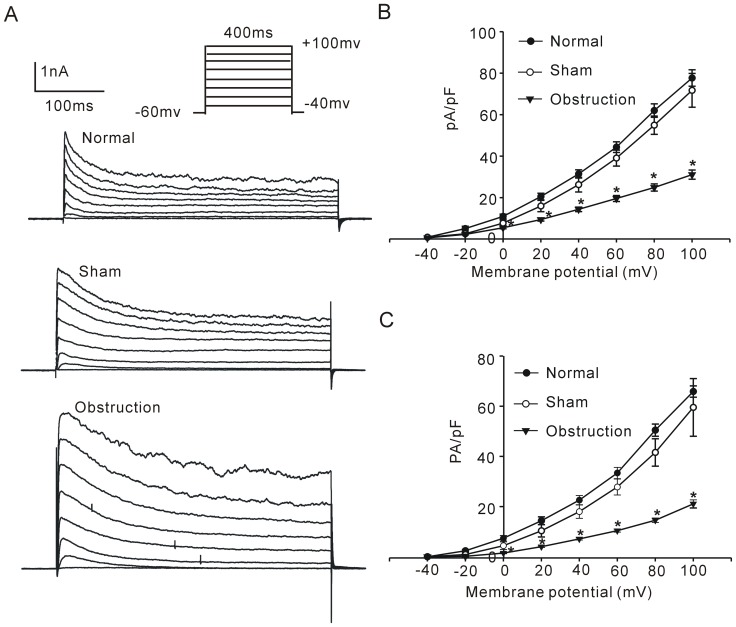
Comparison of IKV in normal sham and obstruction groups.A shows representative current traces elicited from a holding potential of −60 mV using voltage steps of 400 ms from −40 mV to +100 mV in 20 mV increments. Interval between each pulse is 10 s. Averaged current density-voltage relation of IKVpeak (B) and IKVsustained (C) plotted for the smooth muscle cells from normal, sham, and obstruction groups. Data showed the means ± SE *P<0.01 versus sham and normal groups.